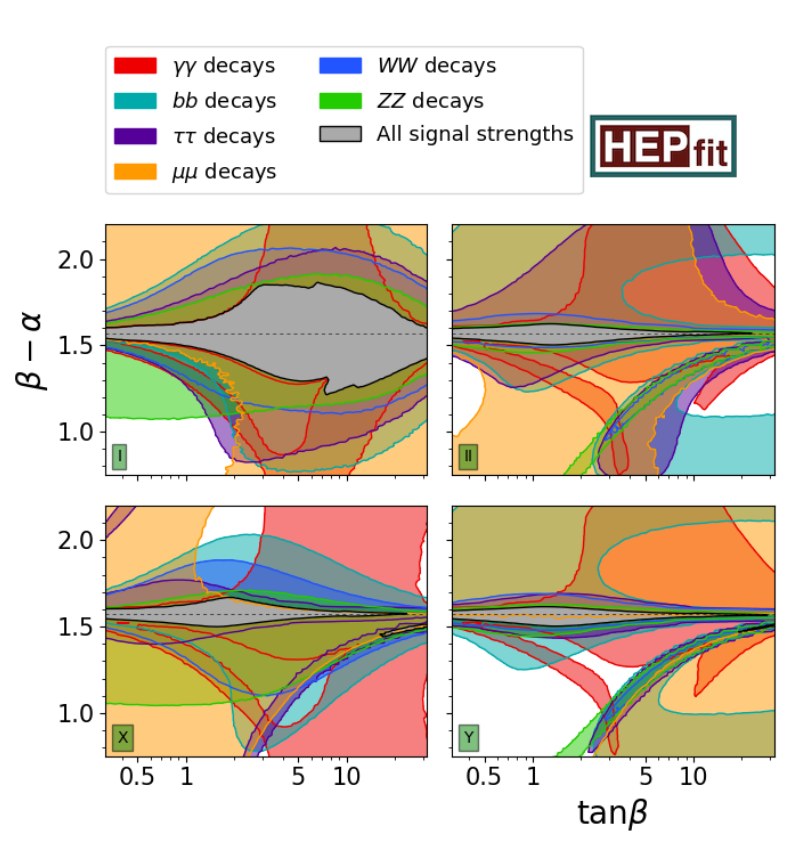
Figure 1 . The impact of the h signal strength measurements is illustrated in the (cid:12) (cid:0) (cid:11) vs. tan (cid:12) plane in all four 2HDM types. We show the 95.4% posterior probability contours for individual (cid:12)ts to data from h decays to (cid:13)(cid:13) , bb , (cid:28)(cid:28) , (cid:22)(cid:22) , WW and ZZ in red, cyan, purple, orange, blue and green, respectively. The resulting 95.4% regions of the combined (cid:12)ts to all signal strengths are the black-bordered grey